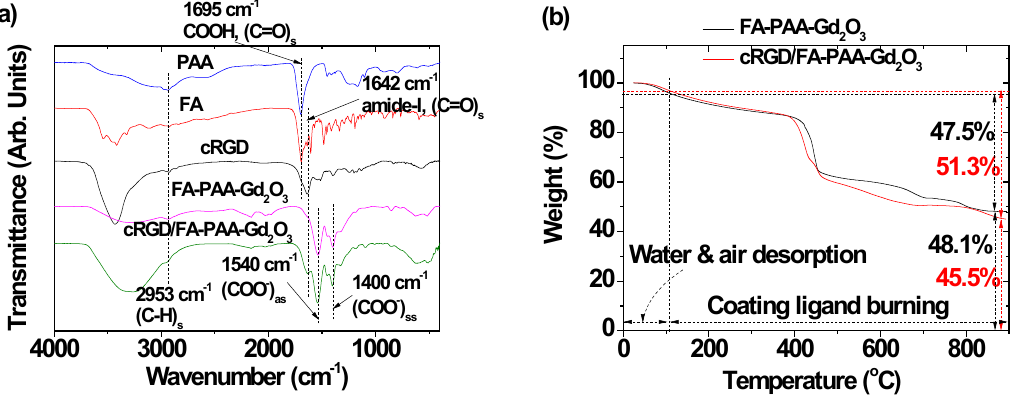
Figure 5. ( a ) FT-IR absorption spectra of PAA, FA, cRGD, FA-PAA-Gd 2 O 3 , and cRGD/FA-PAA-Gd 2 O 3 nanoparticles. ( b ) TGA curves of the FA-PAA-Gd 2 O 3 and cRGD/FA-PAA-Gd 2 O 3 nanoparticles. The surface-coating amount (P; in wt.%) was obtained by TGA. As shown